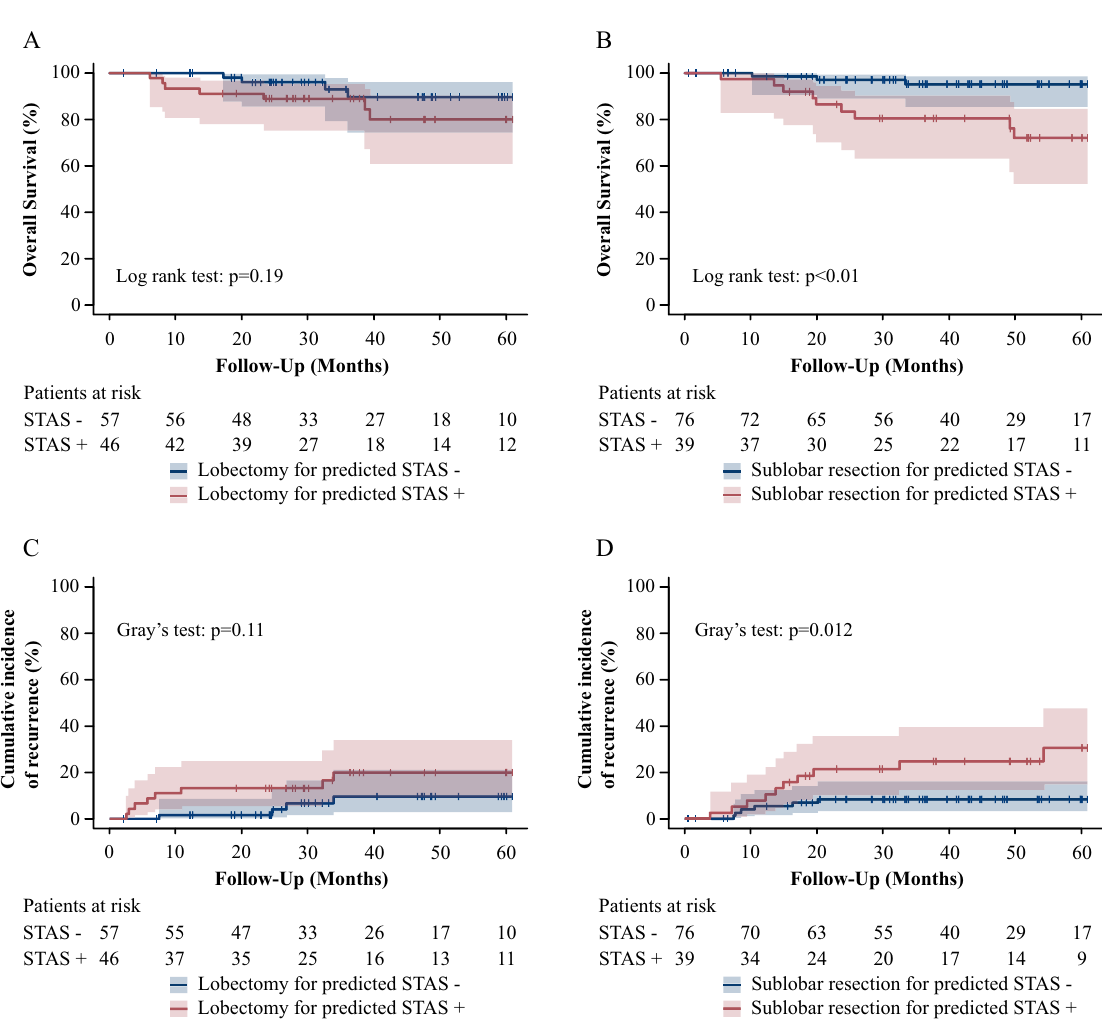
Figure 5. (R version 3.5.1, R Core Team (2018). R: A language and environment for statistical computing. R Foundation for Statistical Computing, Vienna, Austria. URL http:// www.R- proje ct. org/). Survival curves based on the model predicted by radiomics. The OS and CIR associated with predicted-STAS in lobectomy and sublobar resection. Shaded areas represent 95% confidence limits. ( A ) The OS in patients who underwent lobectomy. ( B ) The OS in patients who underwent sublobar resection. ( C ) The CIR in patients who underwent lobectomy. ( D )The CIR in patients who underwent sublobar